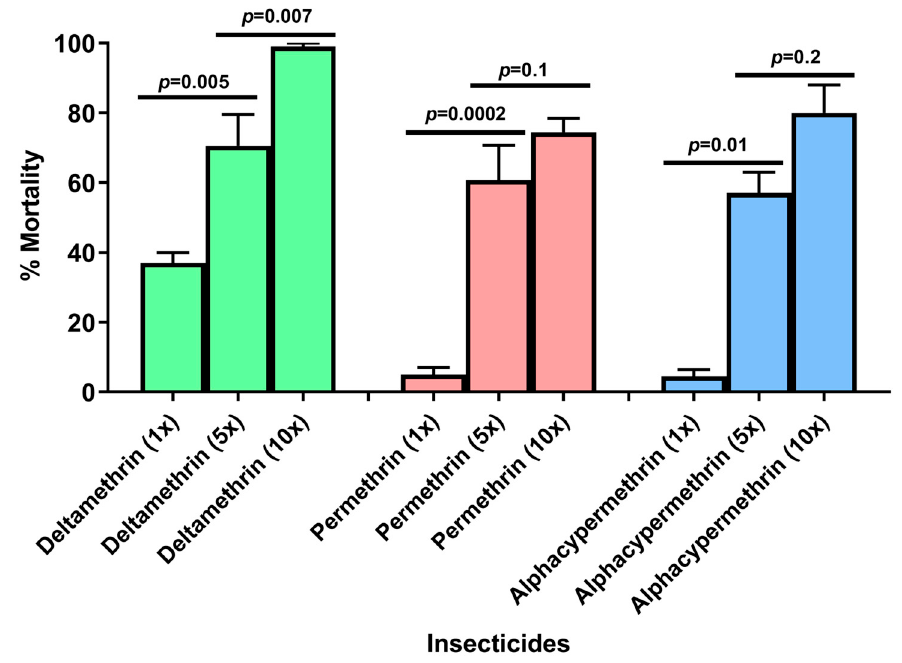
Figure 2. Evolution of the mortality rate according to the concentration of the different insecticides. (The error bars represent the standard error of the mean (SEM) of mortality rate. Green: mortality rate at different doses of deltamethrin; red: mortality rate at different doses of permethrin; blue: mortality rate at different doses of alphacypermethrin).